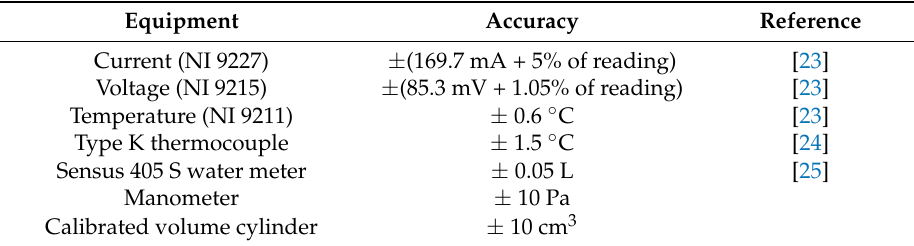
Table 2. Accuracy of the experimental equipment.